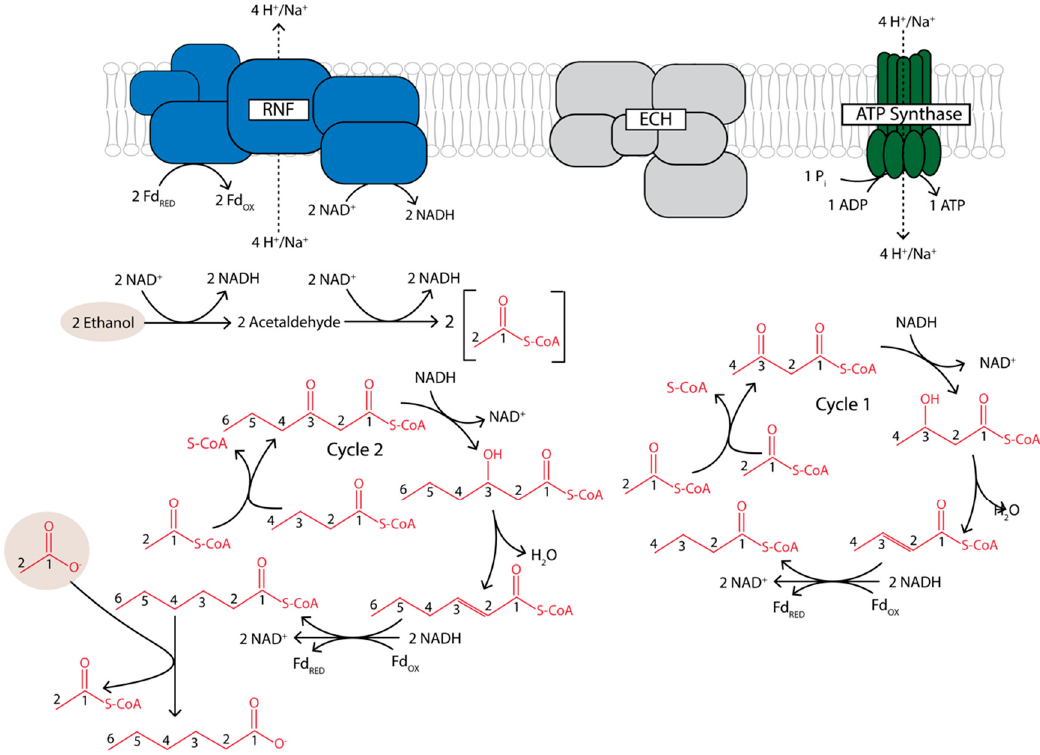
Figure 6. An example model of C6 production from ethanol (2 mols) and acetate (1 mol) without production of H 2 .